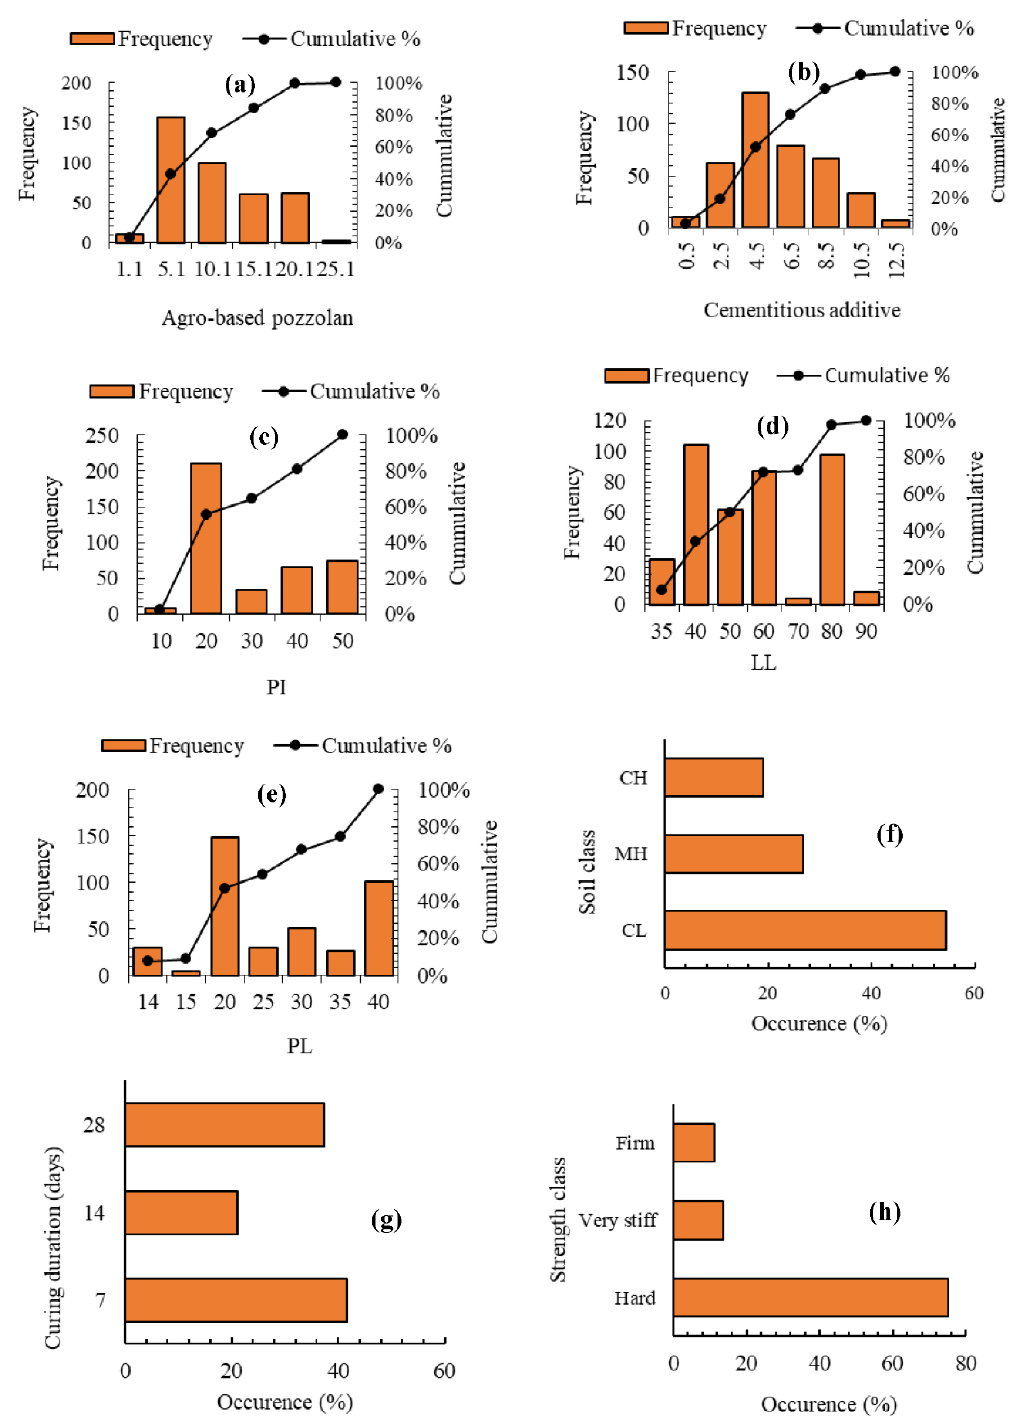
Figure 2. Distribution of input features for ( a ) Agro-based pozzolans; ( b ) Cementitious additives; ( c ) Plasticity index (PI); ( d ) Liquid limit (LL); ( e ) Plastic limit; ( f ) Soil class; ( g ) Curing duration; ( h ) Strength